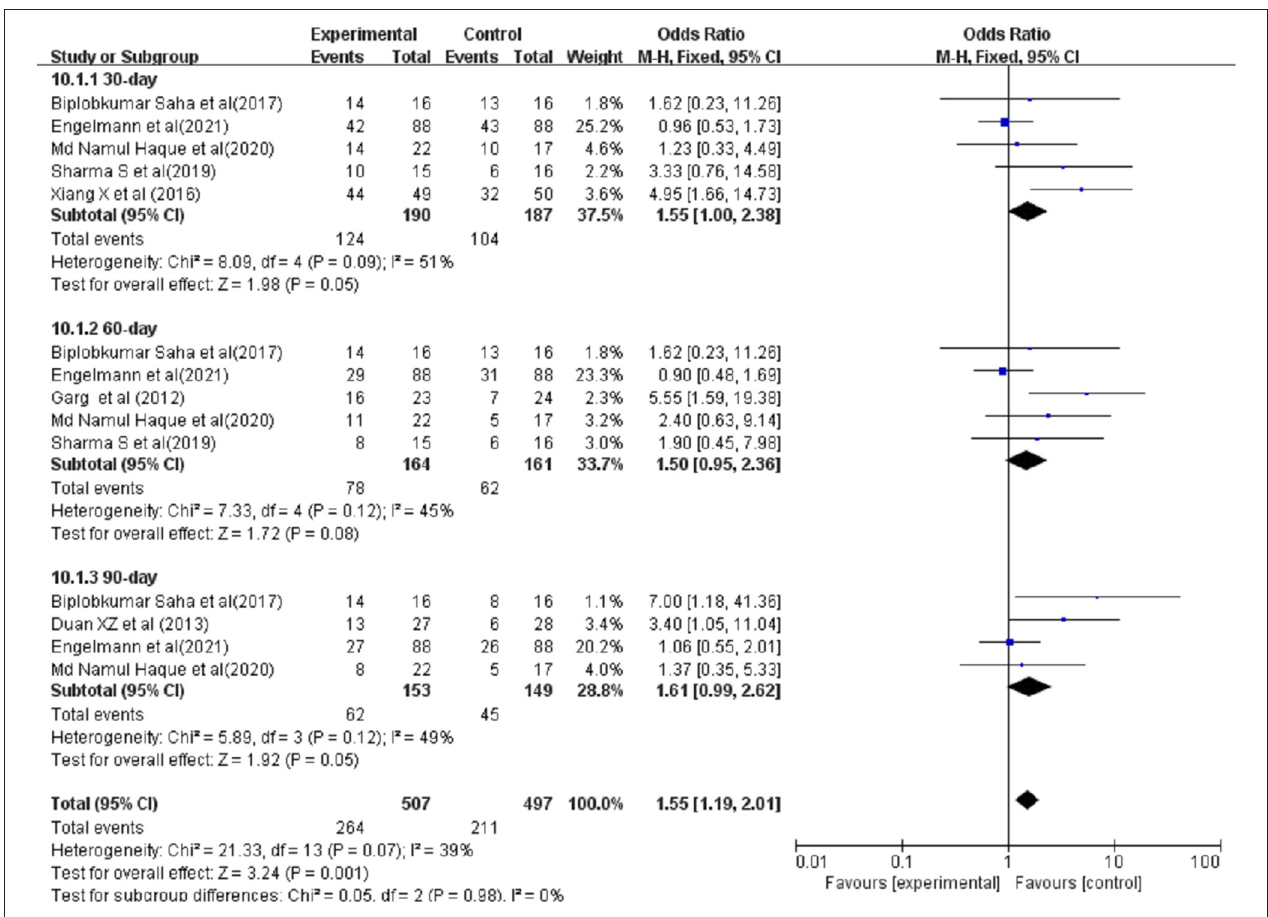
FIGURE 3 | Survival rate between patients with ACLF. Treated by G-CSF and